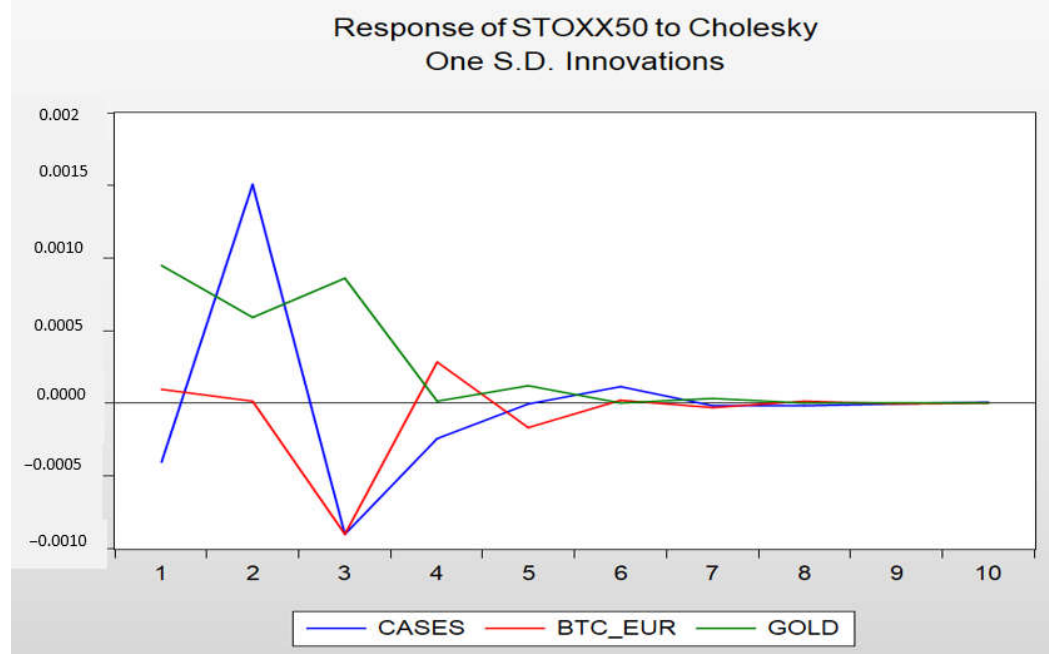
Figure 8. Impulse response of the STOXX50.